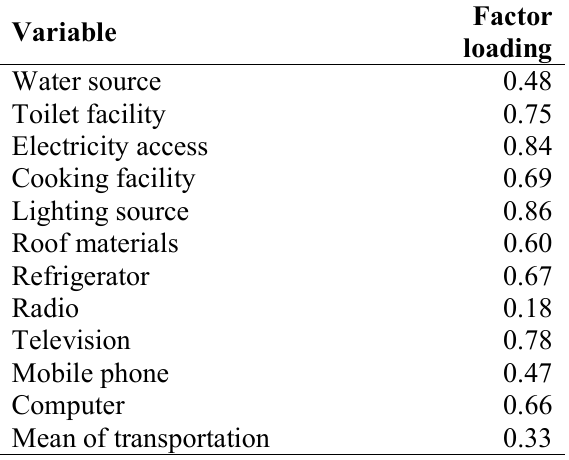
Table A.2. Material Style of Life Principle Component Analysis (PCA) factor